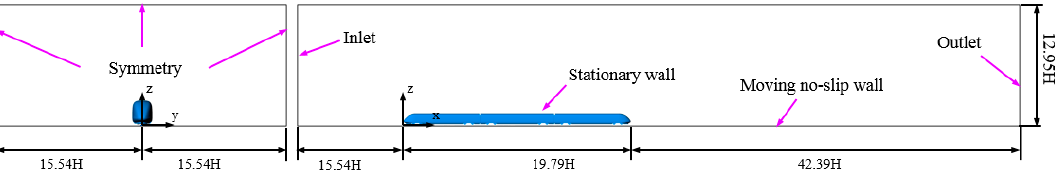
Figure 2. Computational domain and boundary conditions.